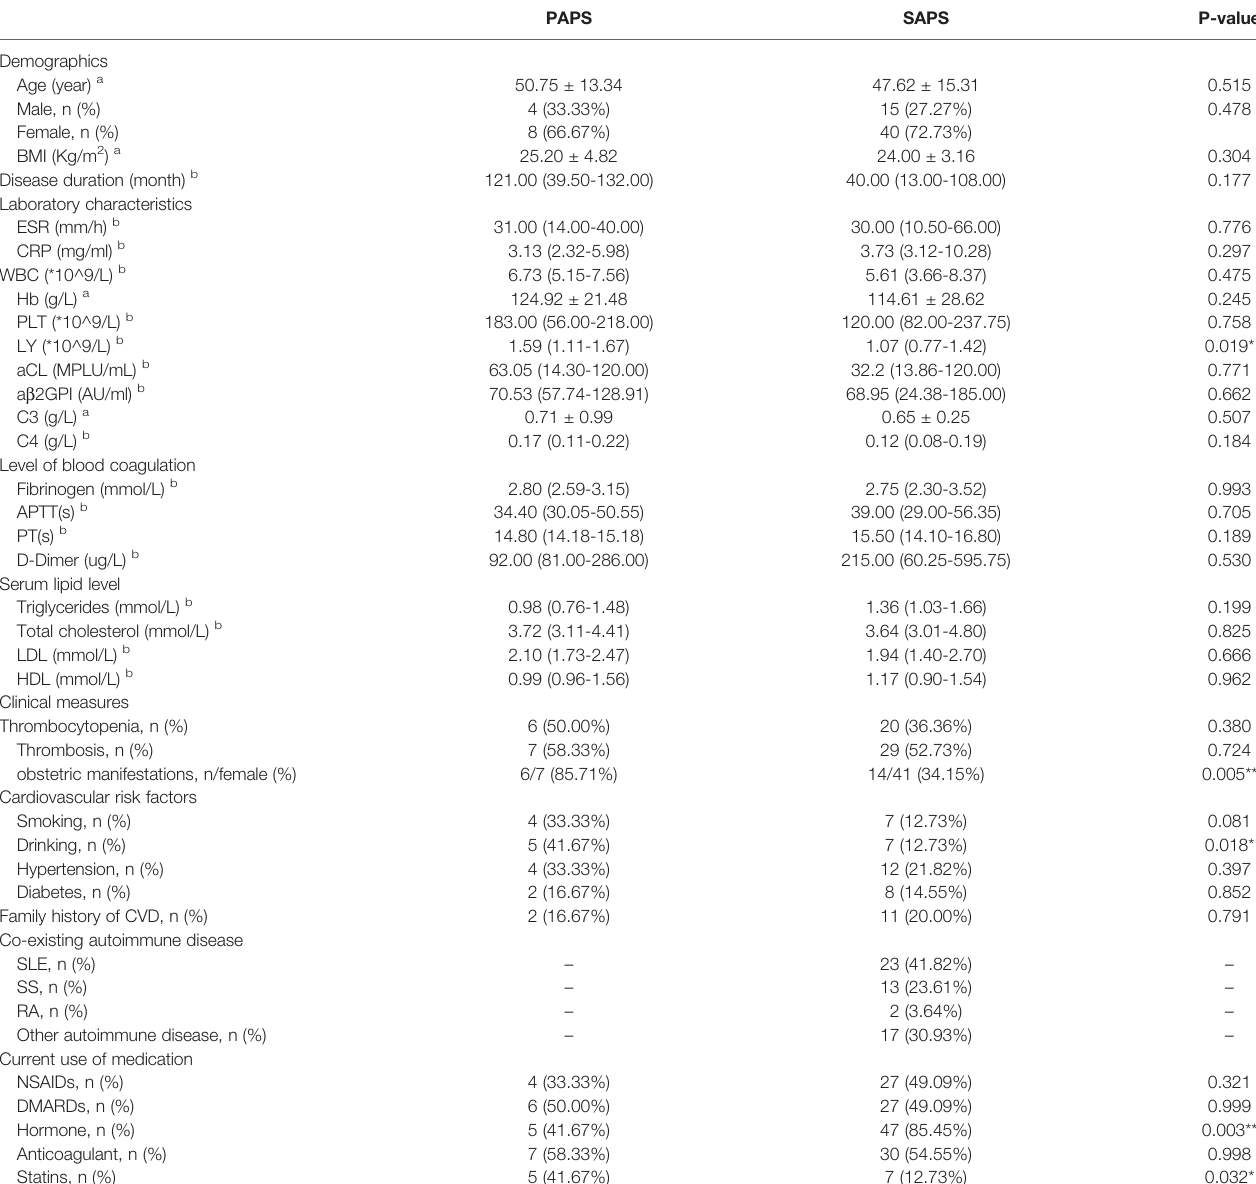
TABLE 1 | Characteristics of PAPS group and SAPS